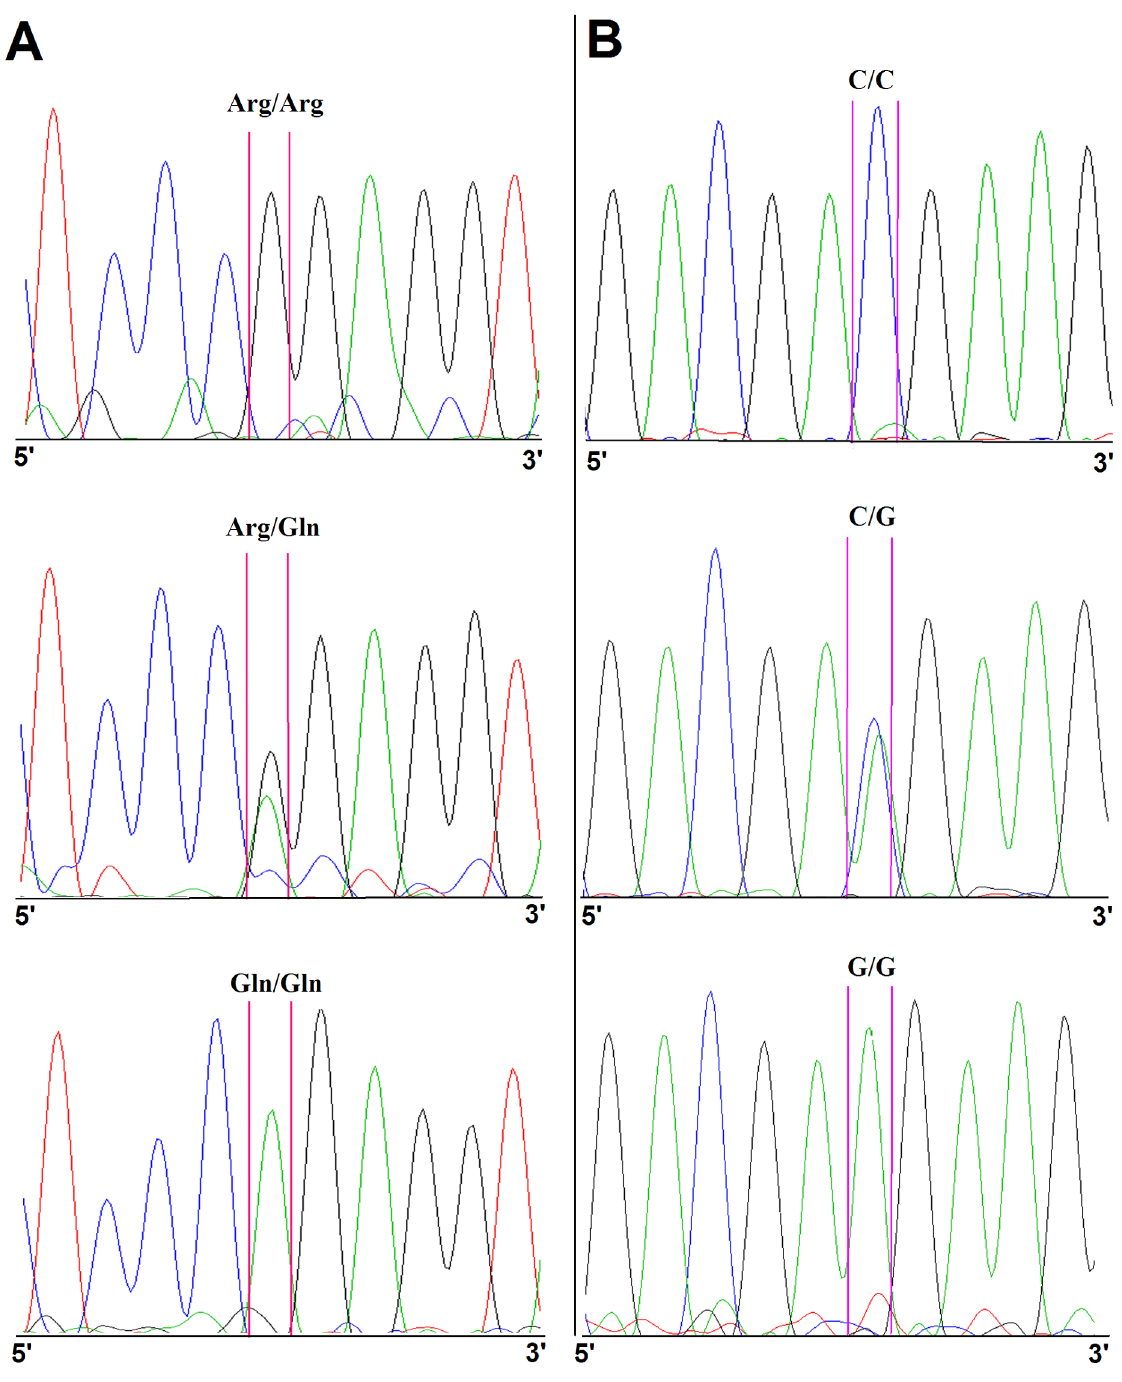
Figure 1. Typical raw data obtained using Sanger sequencing instruments. The area between the two vertical lines indicates the resulting genotypes of XRCC1 Arg 399Gln (A) and ERCC1 Cys8092Ala (B). doi:10.1371/journal.pone.0101256.g001 PFS was detected in subgroups with the XRCC1 399 Gln/Gln or Arg/Gln or the ERCC18092 Ala/Ala genotypes. Representative results of p53 and pAkt immunohistochemical analysis are shown in Figure 3. The effects of combined p53 and pAkt protein expression on risk of disease progression (local recurrence and distant metastases) were examined via stratification analysis according to the XRCC1 Arg399Gln and ERCC1